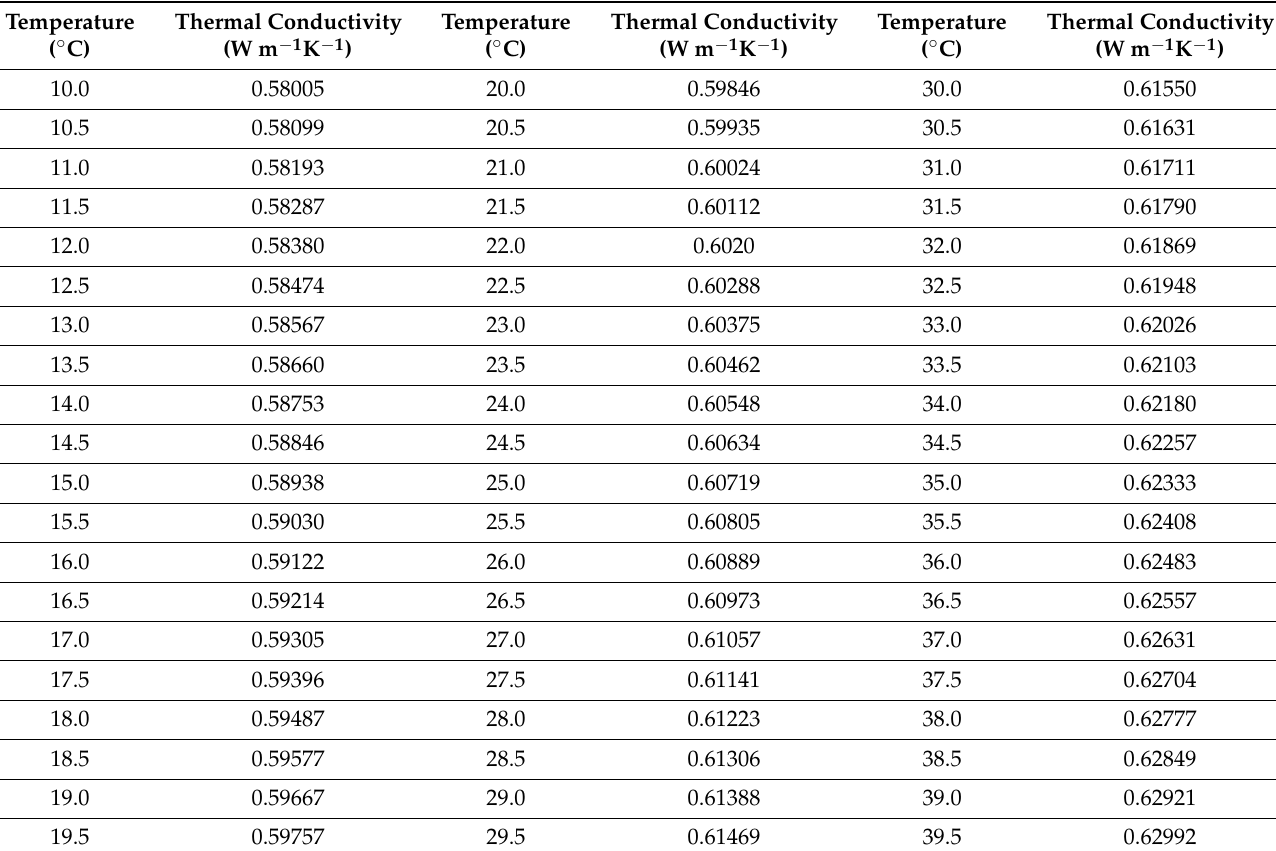
Figure 3. Thermal conductivity of mPCM slurries based on aqueous propylene glycol as a function of temperature.